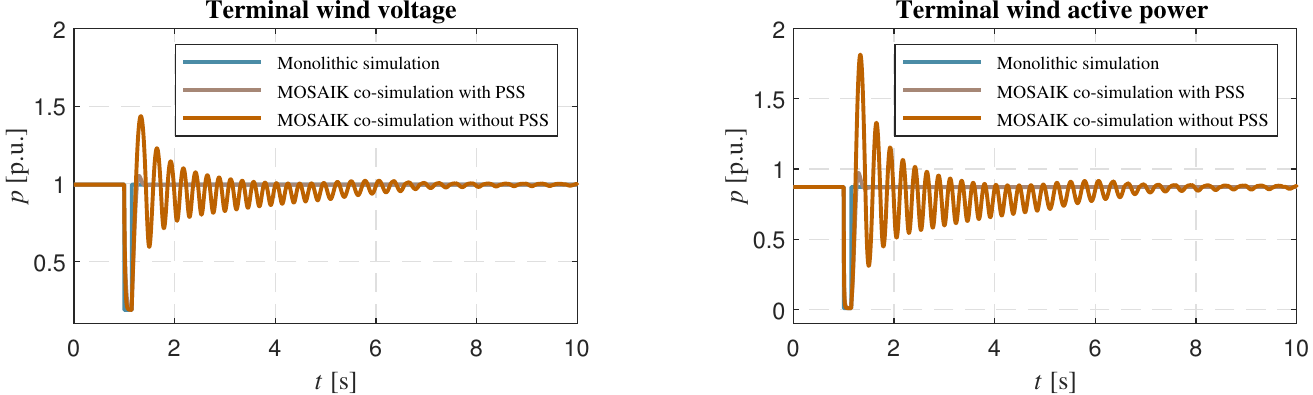
Figure 22. Time-domain response of the wind turbine to a voltage dip in islanded operation, with and without auxiliary damping signal for the MOSAIK based